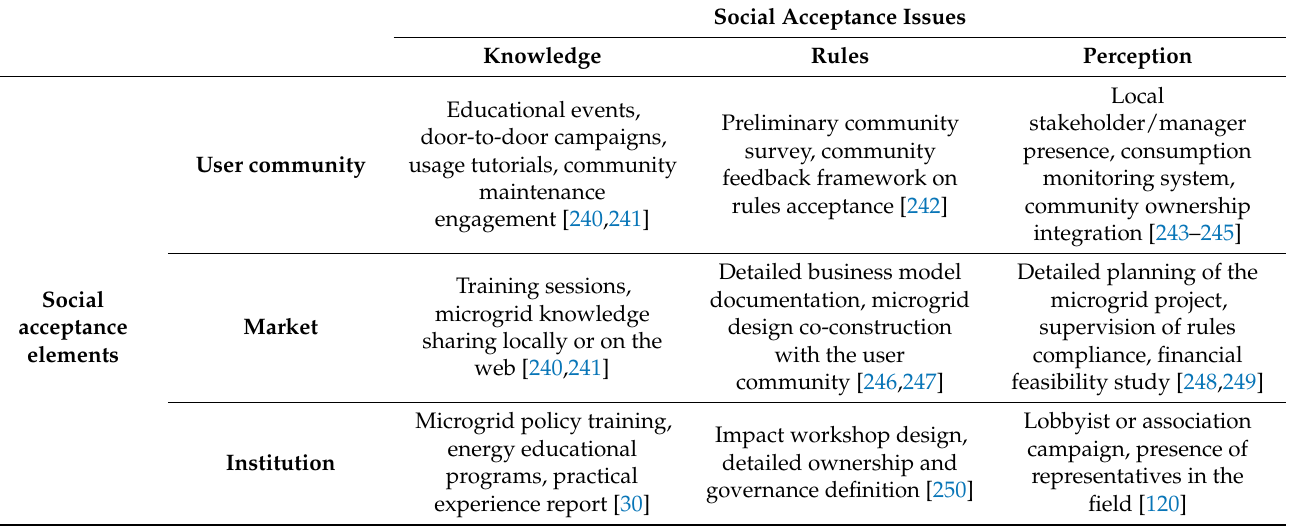
Table 10. Different strategies for social acceptance based on the elements’